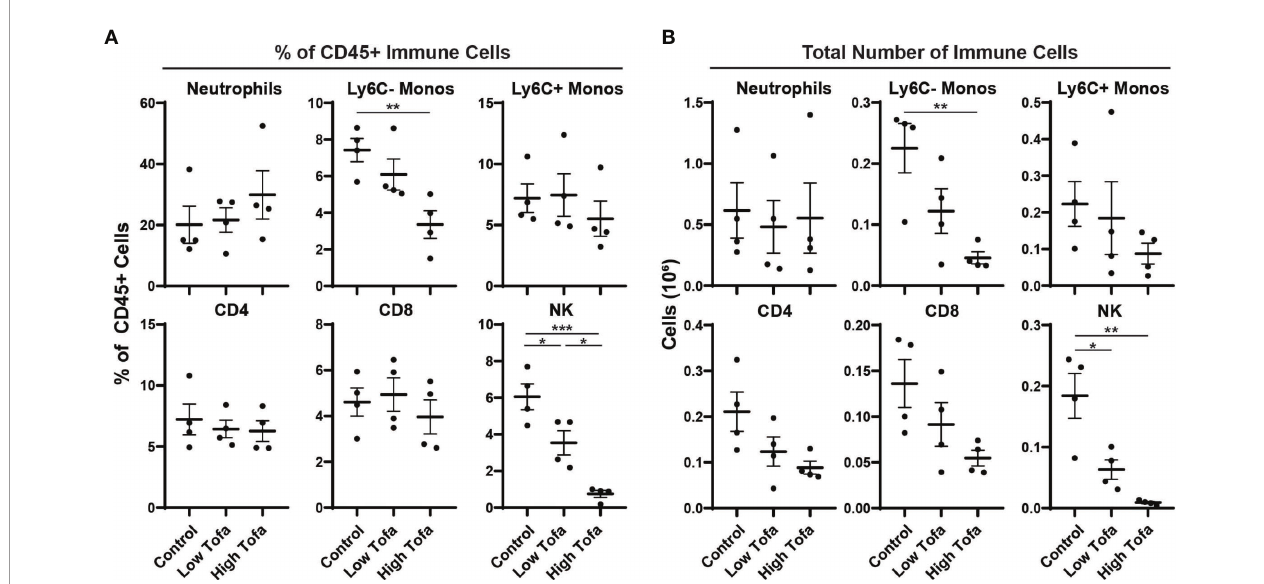
FIGURE 4 | Impact of orally administered tofacitinib on peripheral immune populations in mice. WT control mice (half male and half female) were treated for two weeks with low- (5 mg/kg) and high- (30 mg/kg) dose tofacitinib administered in standard chow. Immune cells were then analyzed in peripheral blood using fl ow cytometry; (A) percentage of all CD45+ immune cells as well as (B) total numbers of cells was examined for six immune populations. Data show mean ± SEM. Comparisons by ANOVA; n = 4 mice per group. * P <0.05, ** P <0.01, *** P <0.001; monos, monocytes.